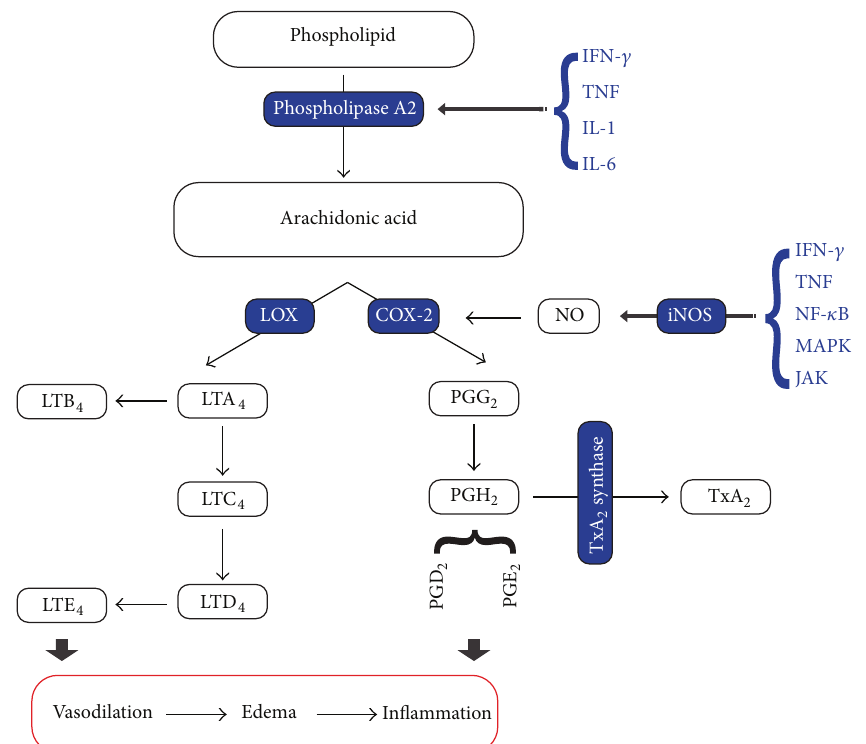
Figure 1: Inflammation pathway. COX, cyclooxygenase; LOX, lipoxygenase; PG, prostaglandin; LT, leukotriene; TX, thromboxane; NO, nitric oxide; iNOS, inducible NO synthase; IFN, interferon; TNF, tumor necrosis factor; NF- 𝜅 B, nuclear factor- 𝜅 B; MAPK, mitogen activated protein kinase; JAK, janus kinase; IL,